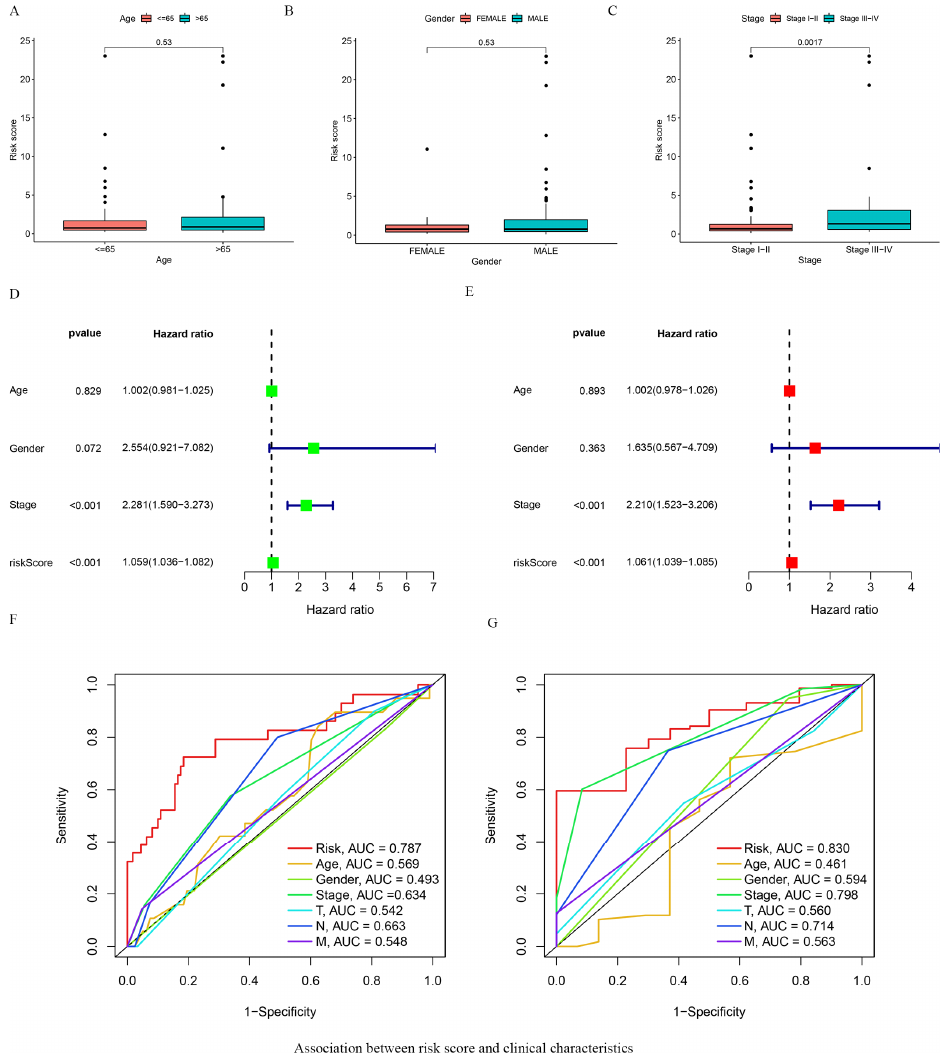
Figure 3. Association between risk score and clinical characteristics. ( A – C ) The association of risk score and clinicopathological features, including age ( A ), gender ( B ), and tumor stage ( C ); The circle represent each individual. ( D ) The univariate Cox regression analysis of clinical parameters in patients with ESCA; ( E ) The multivariate Cox regression analysis of clinical parameters in patients with ESCA; ( F ) ROC curves show 1-year survival in ESCA patients based on risk score and multiple clinical features; ( G ) ROC curves display 3-year survival in ESCA patients based on risk score and multiple clinical features. We excluded patients with deficient clinical information and 124 patients were retained for analysis.Red and green square represent HR